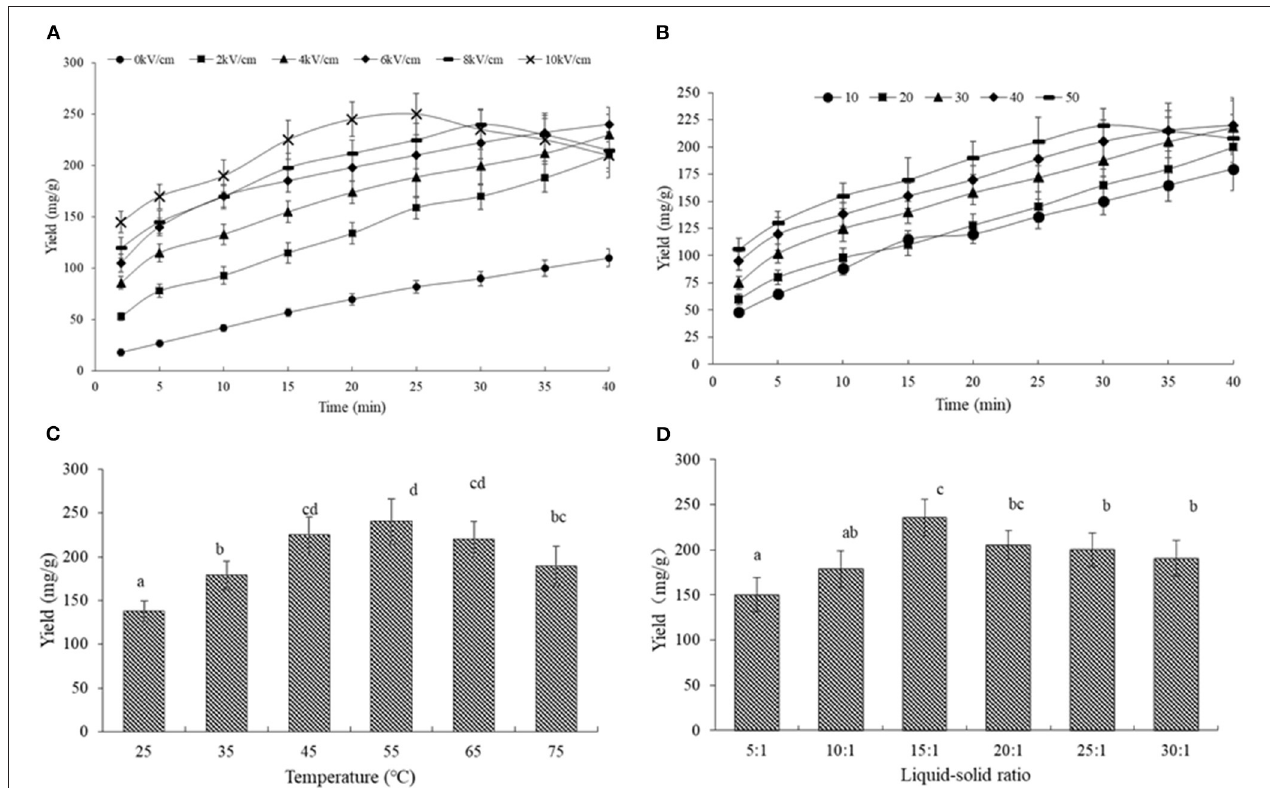
FIGURE 3 | The effects of different parameters on the SDF yield from the orange peel. (A) SDF yield vs. time for all pulse electric field intensity with 30 number; (B) SDF yield vs. time for all pulse numbers at the constant of 6 kV/cm; (C) SDF yield for all temperatures of the constant of 6 kV/cm, 30 number and liquid-solid ratios of 15:1; (D) SDF yield for all liquid-solid ratios of the constant of 6 kV/cm, 30 number, and temperature of 45 ◦ C. Means with different letters are significantly different ( p < 0.05).